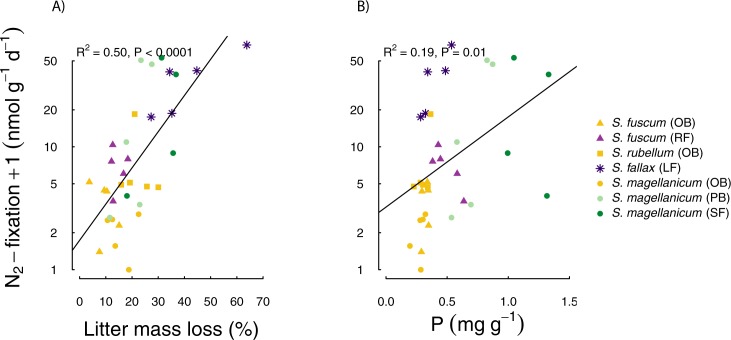
N2 fixation rate +1 on a logarithmic scale, plotted
against A) decomposability (litter mass loss (%) after 7 months
incubation in the lab) and B) P concentration (mg g-1) of
Sphagnum dry weight.